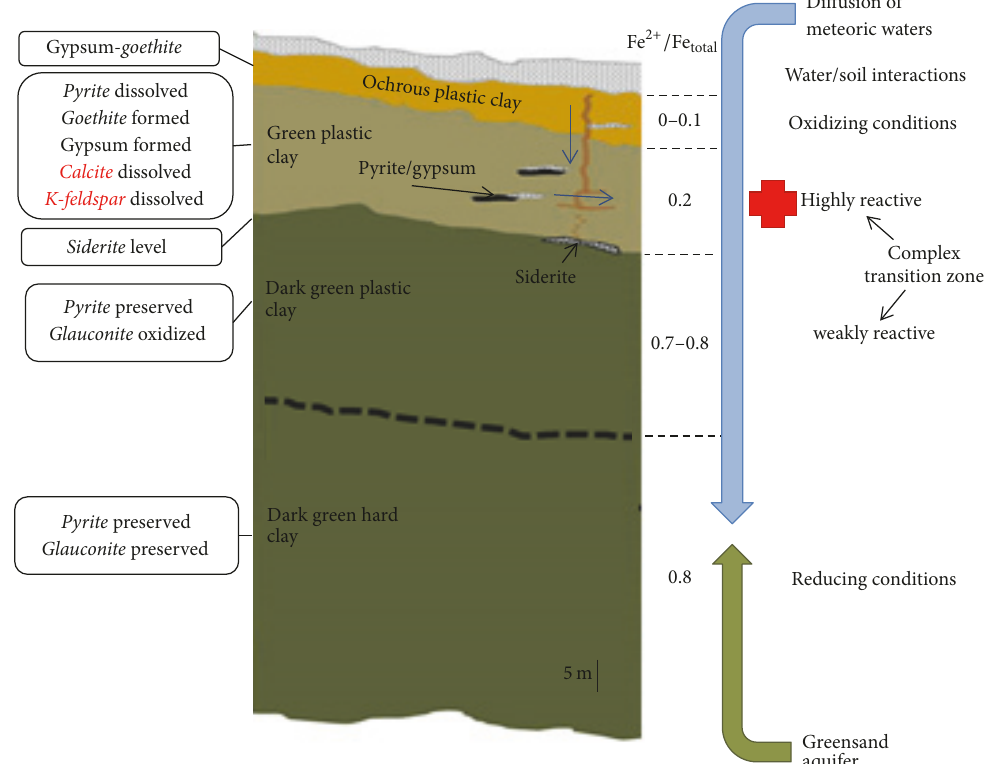
Figure 12: Sketch model of the near-surface redox front in the T´egulines Clay. The different fields are based on color, redox- (in black and bold) and pH-sensitive (in red) minerals, iron which is a redox-sensitive element and plasticity